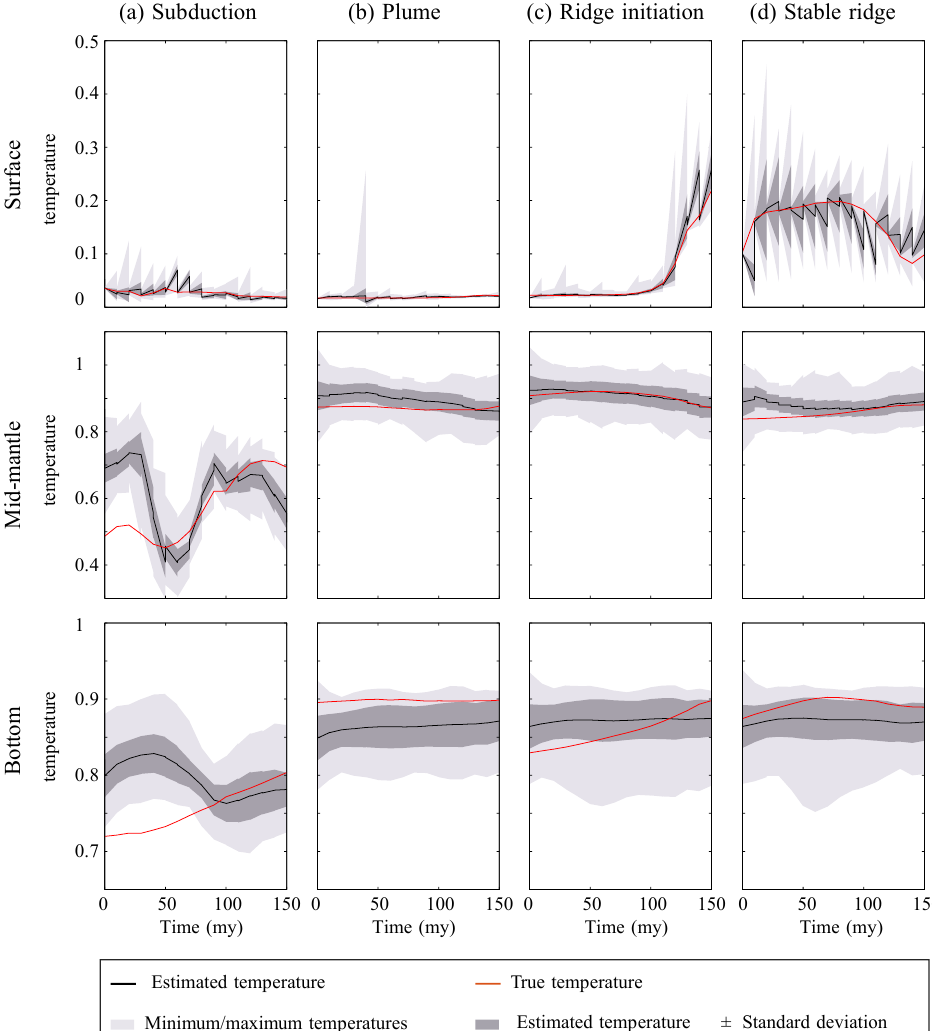
Figure 11. Detailed results of the assimilation depicted in Fig. 10 second row, and Fig. 3a. Each graph represents the time evolution of the temperature value at points on four profiles, corresponding to different geodynamic contexts: (a) a subduction, (b) an upwelling, (c) a ridge initiation and (d) a stable ridge. The first row corresponds to points at the surface of the domain, the second row to points in the mid-mantle and the third row to points at the bottom of the domain. The lateral coordinates of the points are shown in Fig. 10 (second row first column). The red line is the true temperature, the black line is the average of the ensemble, the dark grey area represent the average plus or minus the standard deviation of the ensemble and the light gray area is the area spanned by the minimum and the maximum value taken by the ensemble of 288